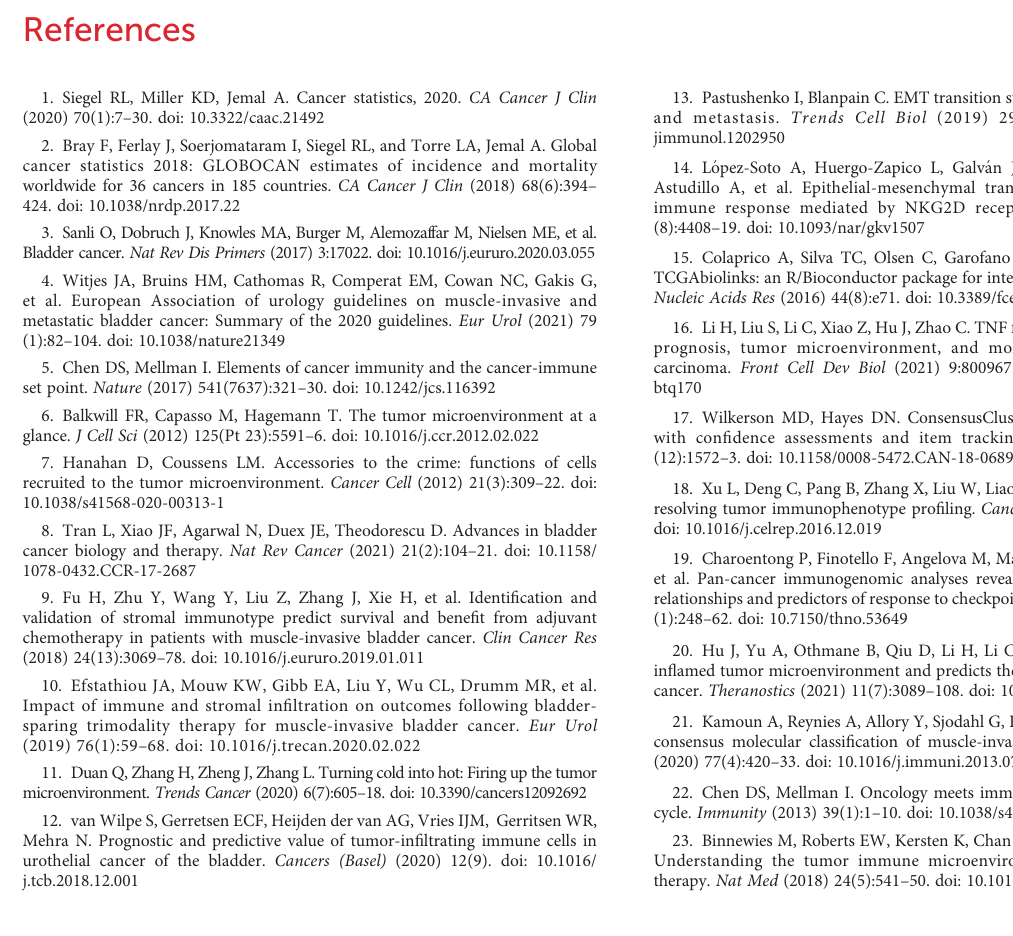
SUPPLEMENTARY TABLE 13 The association between EMT risk score, ICI genes and TIS genes in the TCGA-BLCA